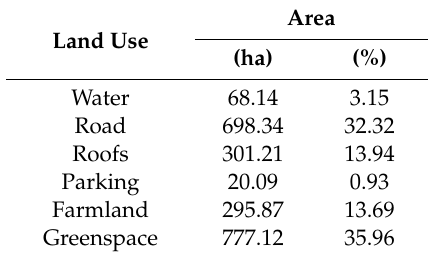
Figure 2. Maps of study area: ( a ) location of Xining and study area in China; ( b ) DEM (Digital Elevation Model) of study area including natural rivers; ( c ) pipe networks in study area. Table 1. Land-use characteristics of the study area.